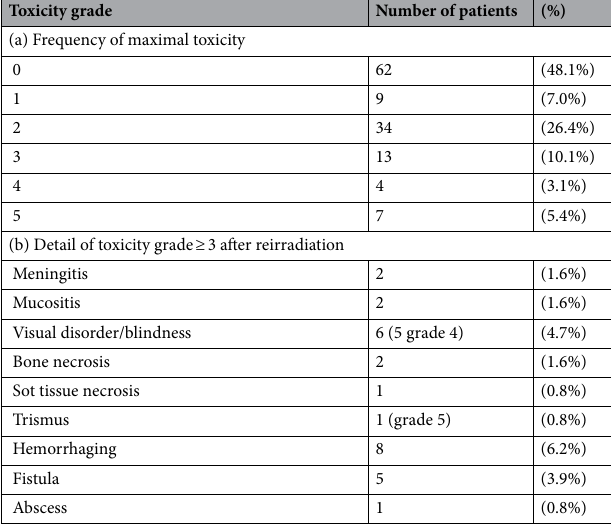
Table 3. Toxicity. Some patients had two or more toxicities.